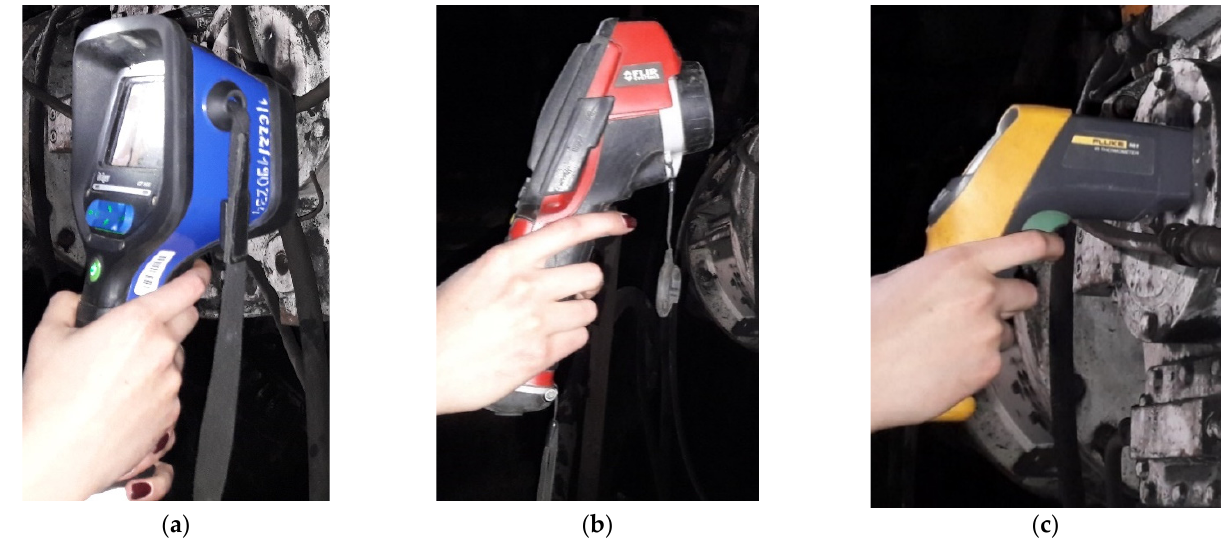
Figure 3. The measuring equipment used in the study of the thermal condition of the belt conveyor drive unit: ( a ) Dräger UFC 9000 thermal imaging karma; ( b ) FLIR i60 thermal imaging camera; ( c ) FLUKE 561 pyrometer.